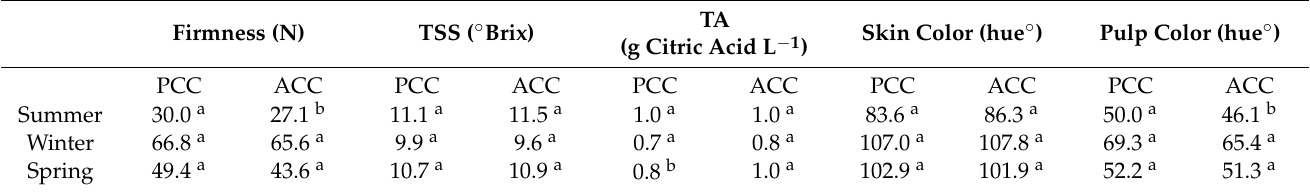
Table 4. Fruit quality in “Siluet” papaya grown in passive climate control (PCC) and active climate control (ACC) modules (fruit 50% skin yellow harvested in summer 2017, winter and spring 2018).